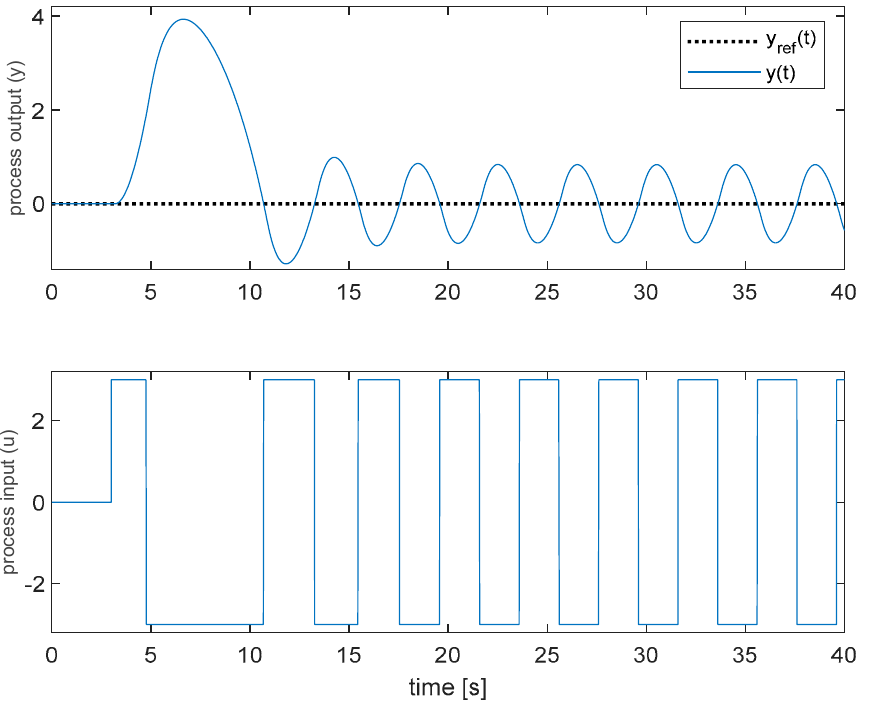
Figure 19. Response of the proposed method for the unstable process and (cid:1842)(cid:1827) (cid:3046)(cid:3032)(cid:3047) = −(cid:2024) .